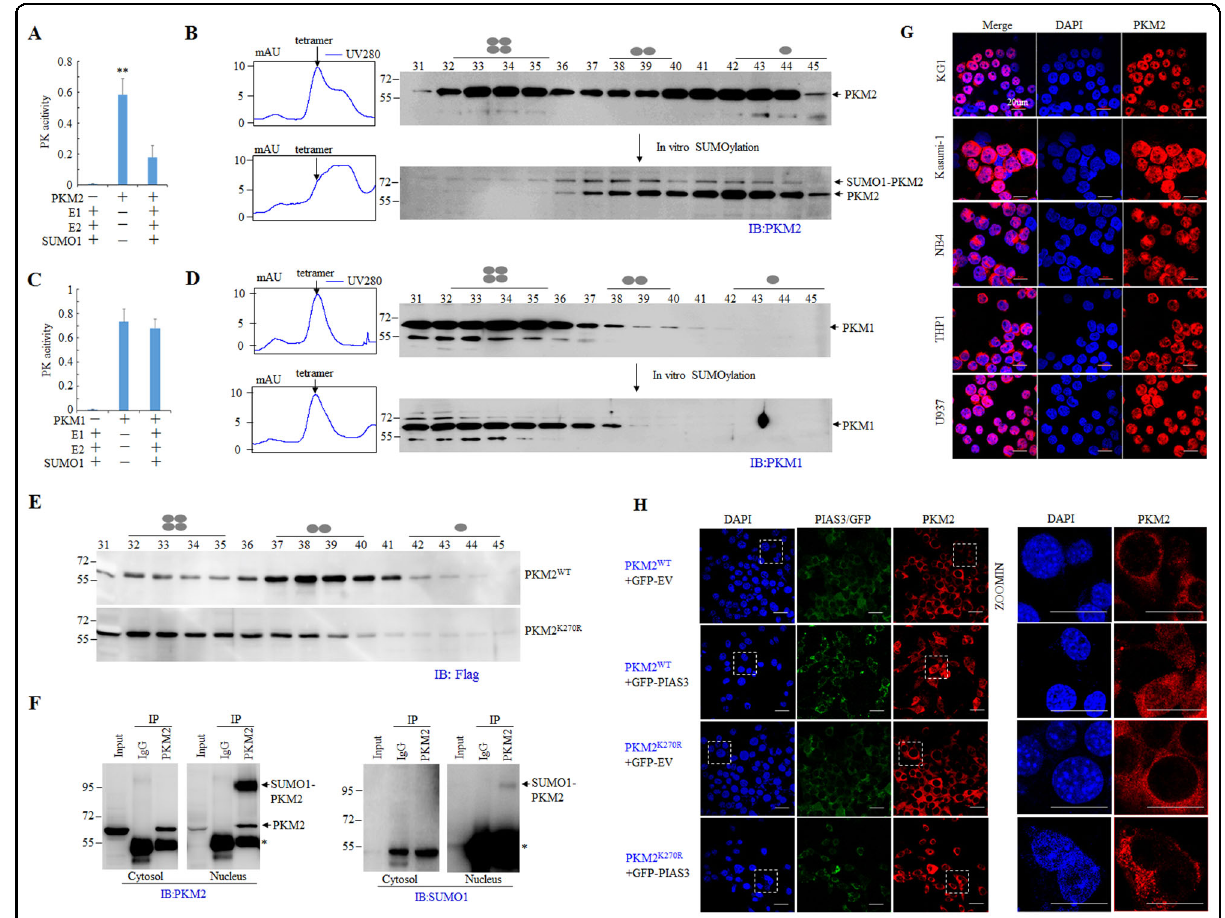
Fig. 3 SUMO1 modi fi cation suppresses pyruvate kinase of PKM2, disassembles PKM2 tetramer and induces nuclear localization of PKM2. A , C In vitro SUMOylation reaction were performed by incubating recombinant PKM2 ( A ) or PKM1 ( C ) with puri fi ed SUMO1, E1 and E2. The samples were subjected to pyruvate kinase assay. B , D Size-exclusion chromatography analysis of samples from in vitro SUMOylation reaction followed by western blot analysis with anti-PKM2 ( B ) or anti-PKM1 ( D ) antibody. The UV absorbance were shown on the left. According to the molecular weight, the four, two, or one ellipse represents tetramer, dimer, or monomer of PKM2, respectively. E 32D BCR-ABL cells were ectopically expressed Flag-tagged WT PKM2(PKM2 WT ) or K270R mutant PKM2(PKM2 K270R ). The cell lysate was prepared and analyzed by size-exclusion chromatography. F Cytosolic and nuclear extracts were prepared from NB4 cells followed by IP with anti-PKM2 antibody and western blot analysis for the indicated proteins. G Immuno fl uorescent staining of endogenous PKM2 in leukemia cell lines with antibody against PKM2. H NIH3T3 cells were co-transfected with PIAS3 and WT or K270 mutant PKM2 plasmids followed by immuno fl uorescent staining. The right panel showed the ampli fi ed images for cells lined with white